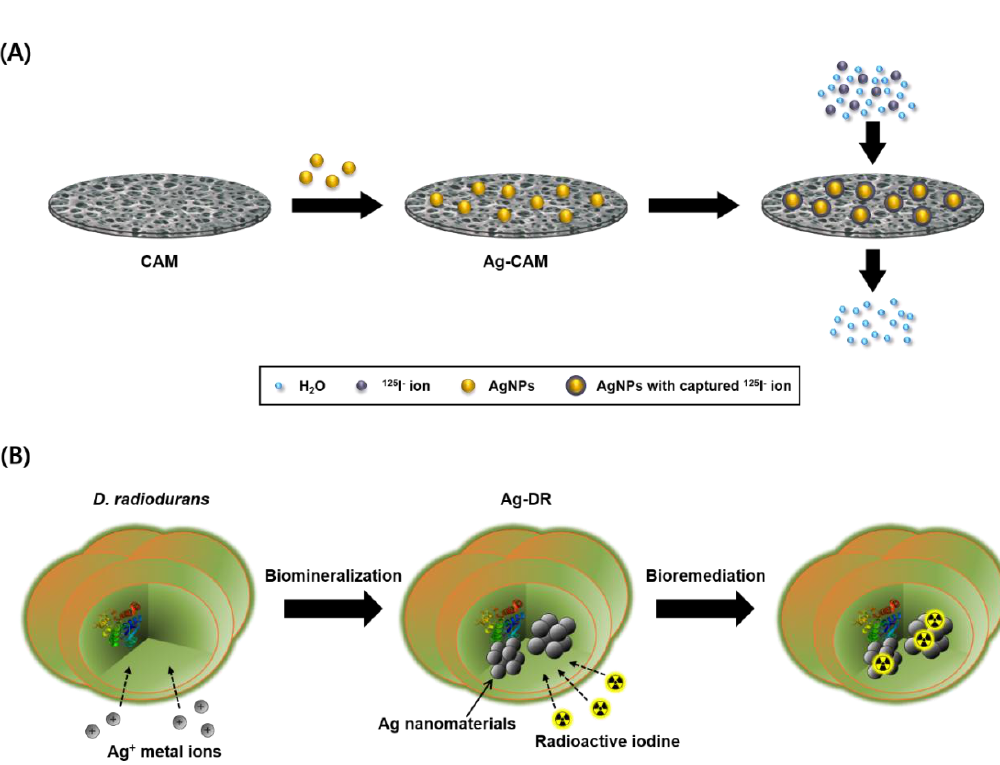
Figure 1. ( A ) Desalination of radioactive iodine by using Ag-CAM; and ( B ) bioremediation procedure of radioactive iodine anions using Ag-DR.